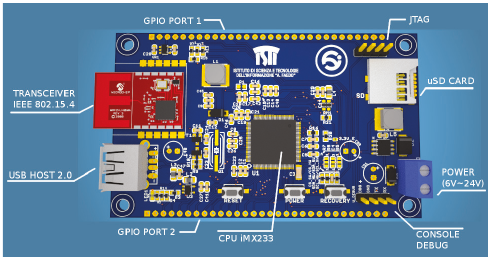
Figure 6: Top view design of the vision board.